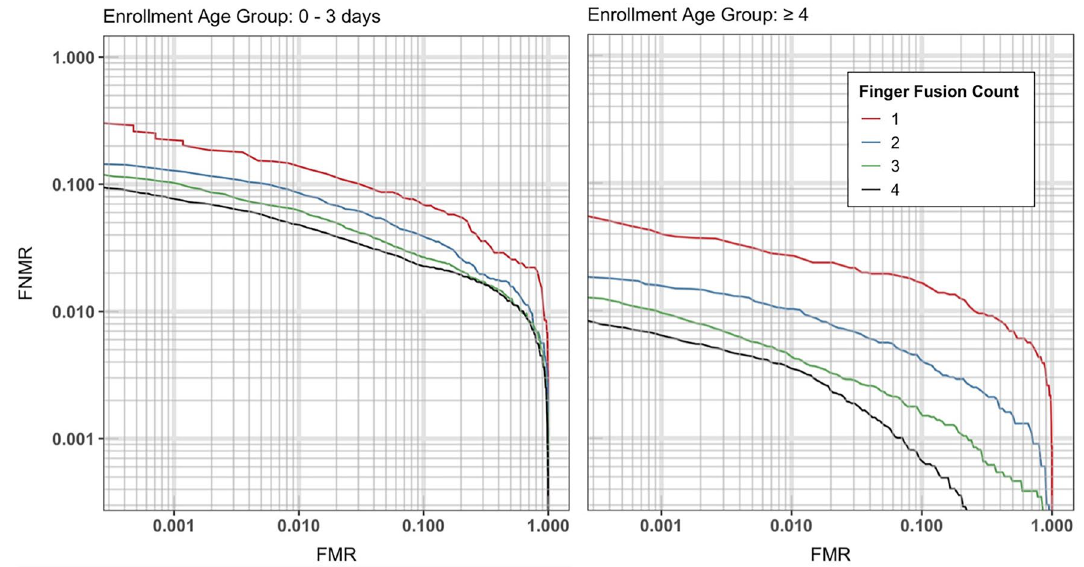
Figure 2. Effect of enrollment age and number of fingers used on the verification performance for (Left) 0–3 day age enrollment and (Right) > 3 day age enrollment with a verification time gap of 15–30 days. True accept rate @ FMR =